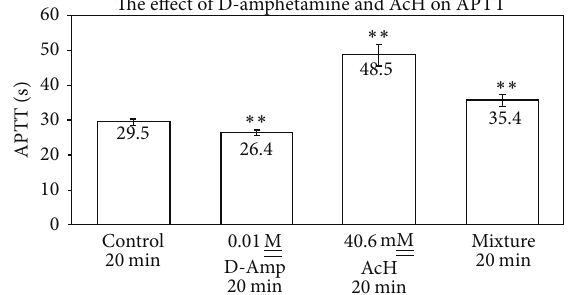
Figure 4: The effect of D-amphetamine and AcH on APTT ( 𝑛 = 10 ; 𝑃 ≤ 0.01 for the D-Amp-AcH mixture).